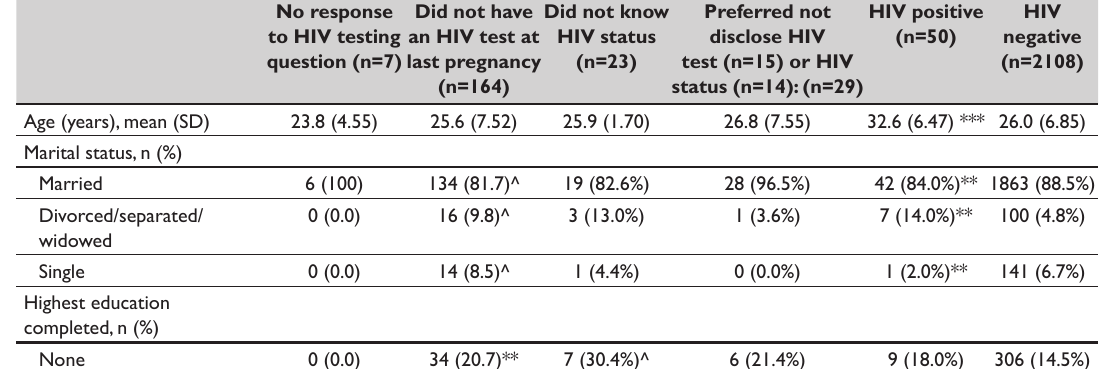
Table I: Maternal demographics by HIV test status and HIV status No response to HIV